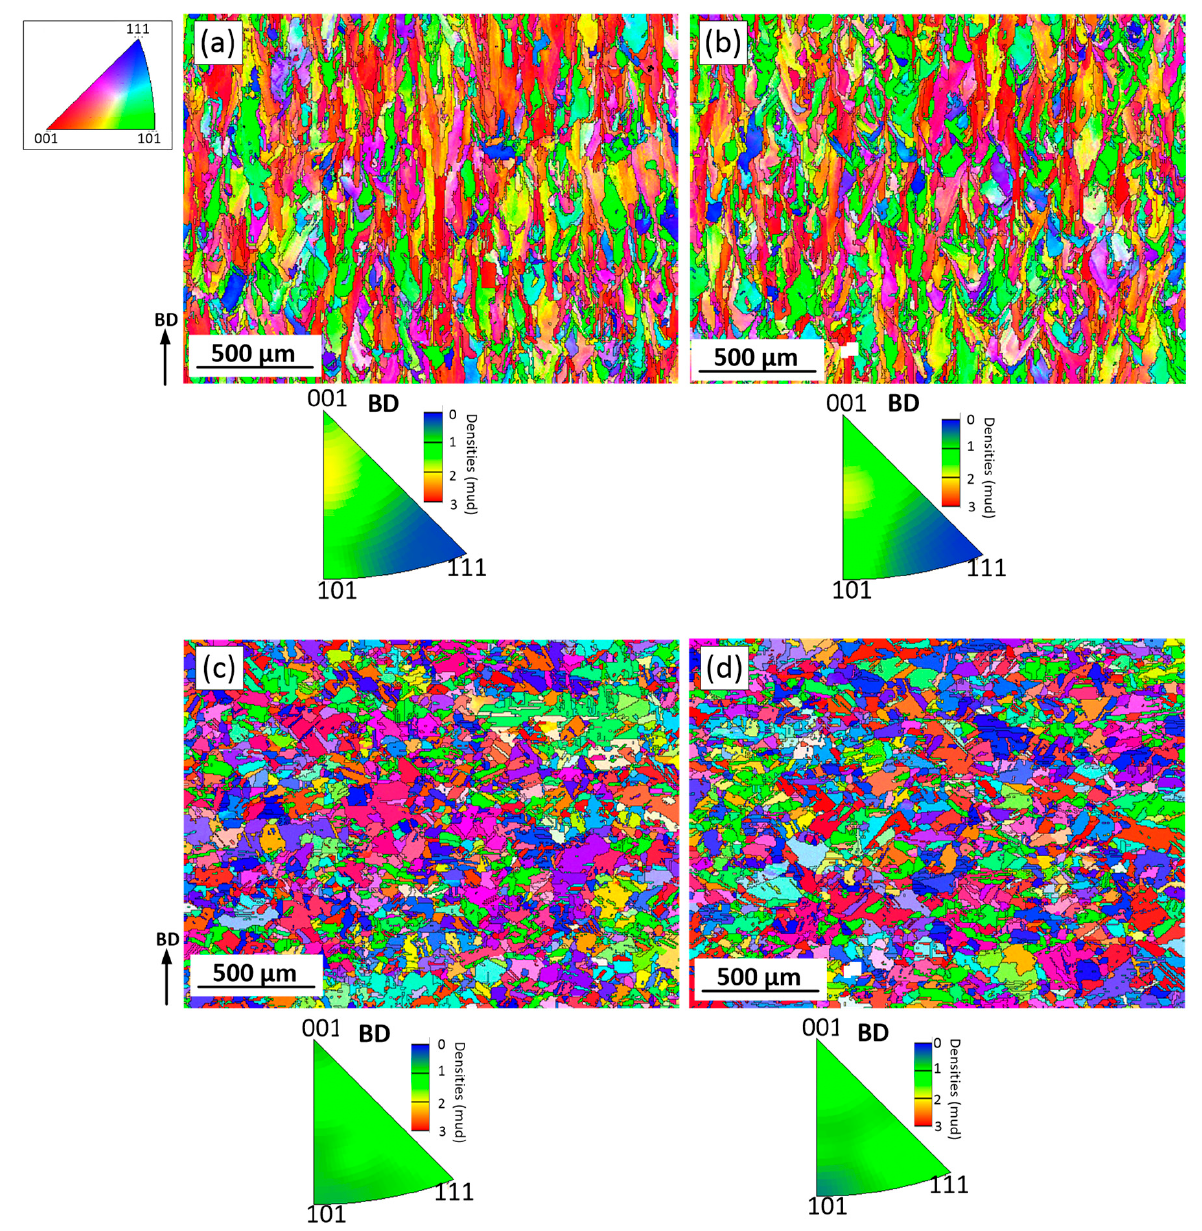
Figure 10. Orientation image microscopy (OIM) maps and inverse pole figures in the ZX plane (IPFs) of ( a , c ) Alloy 1 and ( b , d ) Alloy 2. ( a , b ) after SR; ( c , d ) after ST.